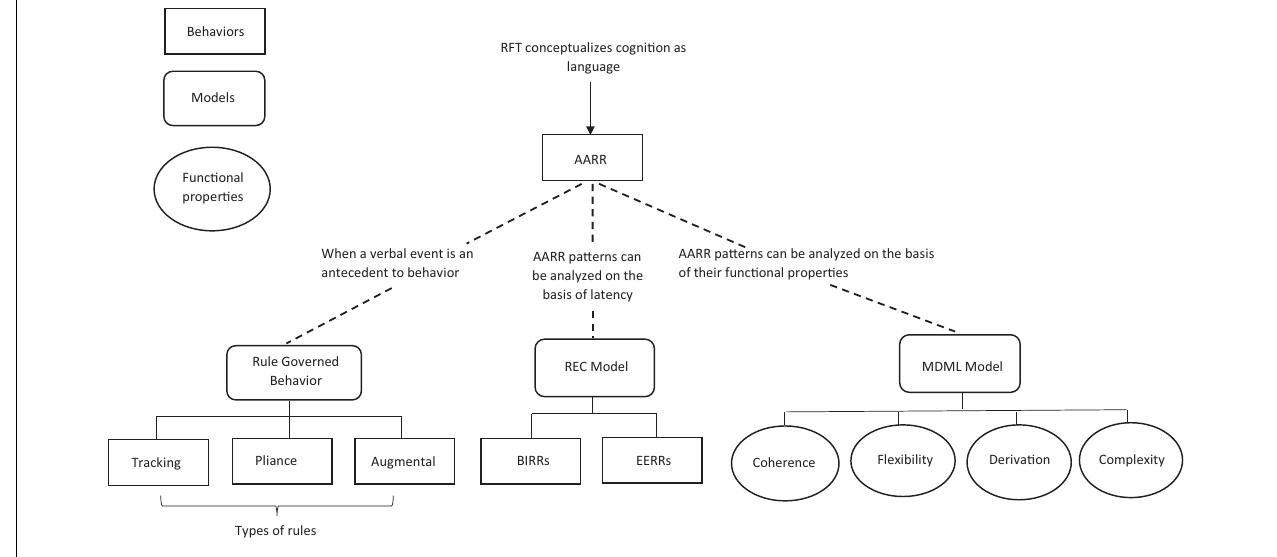
FIGURE 6 | The adapted REC RFT framework of cognition which includes fast and slower responding. Image has been redrawn and adapted from Tagliabue et al. (2019), open access, permission to reuse and adapt